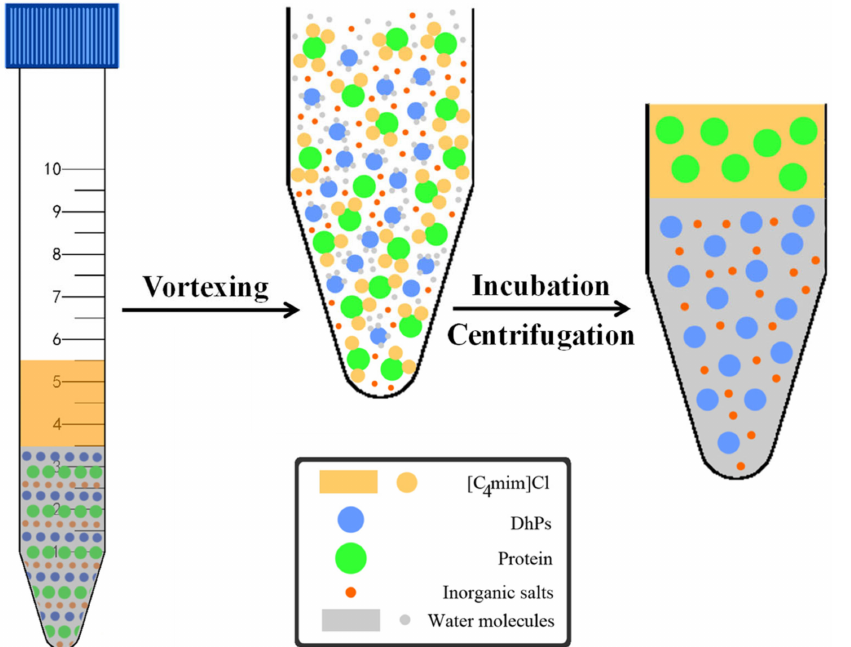
Figure 8. Extraction procedure and mechanisms of DhPs and protein separation in